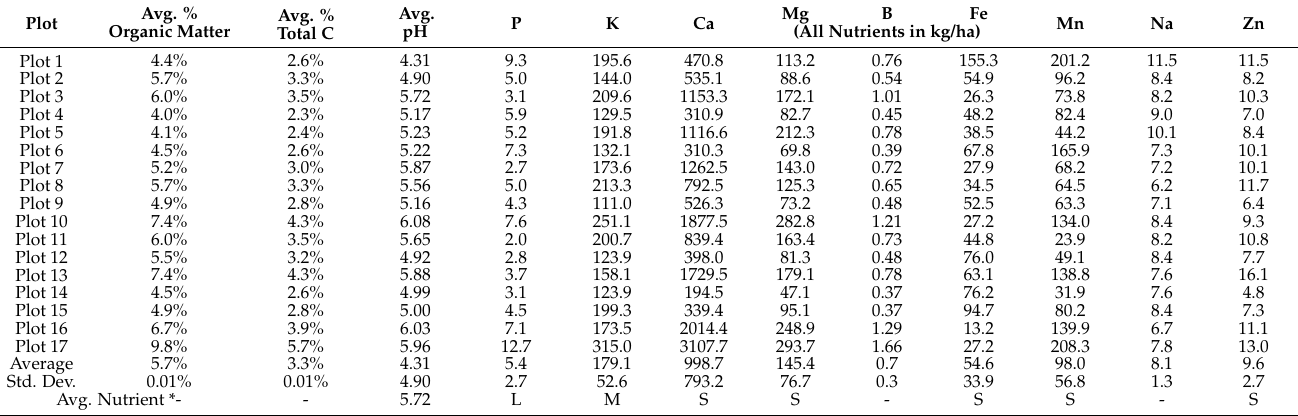
Table A4. Results of organic matter, total carbon, pH, and plant available nutrient analyses ( n =